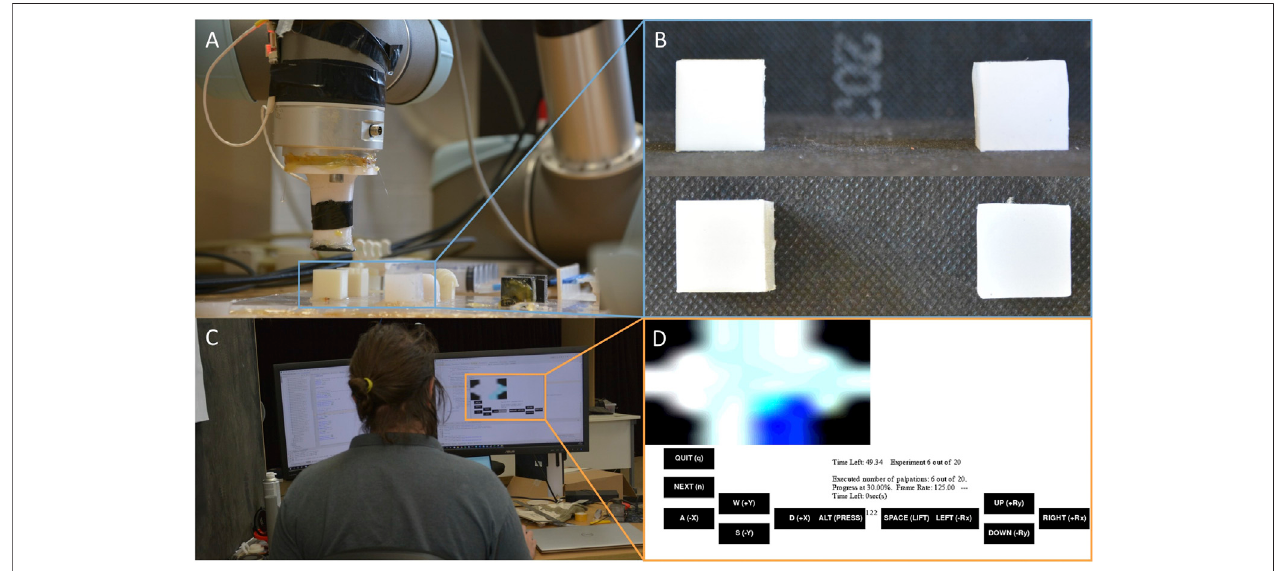
FIGURE1|(A) Theteleoperated robotwithcapacitivepressuresensorattheend-effector, (B) thelateralandtopviewofthetwodummiesusedintheexperiment, (C) the subject remotely controlling the robot with the keyboard, and (D) the interface showed by the leader with the visual map of haptic data.